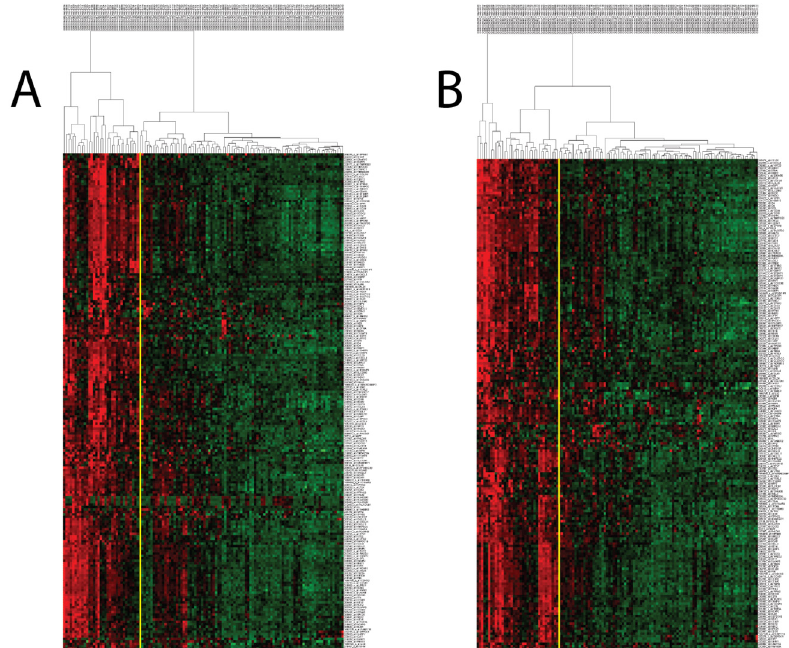
Figure 1. Hierarchical clustering of CHB livers in GSE83148 ( A ) and GSE84044 ( B ) with PCM1 probesets reveals the presence of two distinct sample groups. Expression values of 204 and 197 probesets (rows) identified in Supplementary Figure S1 (Cluster 6) were used to analyze CHB livers (columns), showing the two sample groups (PCM1 ‐ U and PCM1 ‐ D). Red, black and green colors indicate high, moderate and low expression, respectively. The yellow vertical line indicates the demarcation of the two sample clusters.